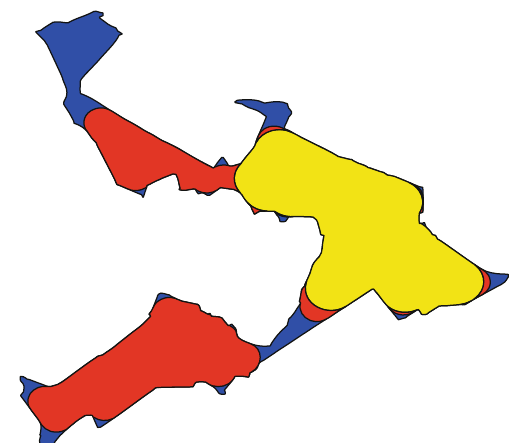
Figure 6: Numerical example illustrating the three-phase con fi guration of gas (yellow region), oil (red region), and water (blue region) after the fi rst iteration step in the extracted pore space from Bentheim